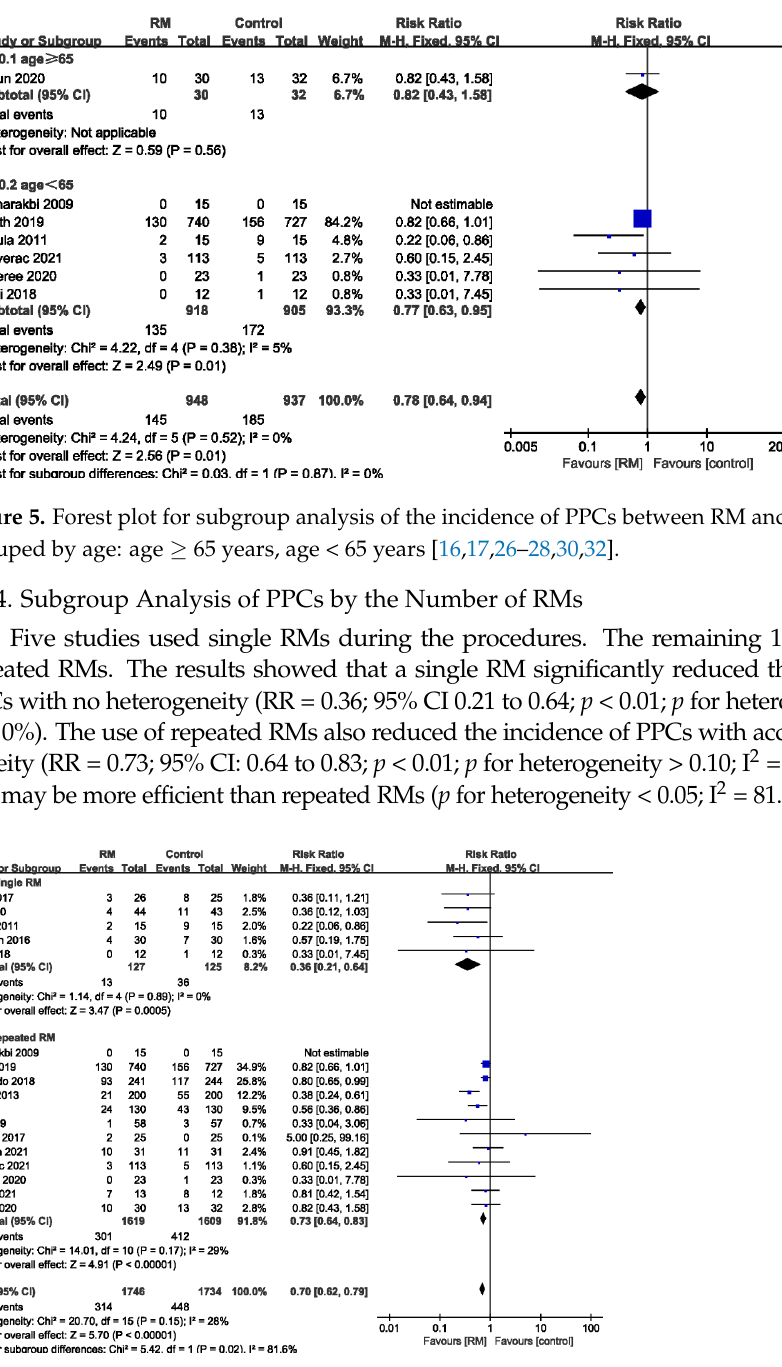
Figure 4. Forest plot for subgroup analysis of the incidence of PPCs between RM and control groups. Grouped by BMI: BMI ≥ 35 kg/m 2 , BMI < 35 kg/m 2 [17 – 28,30,31].